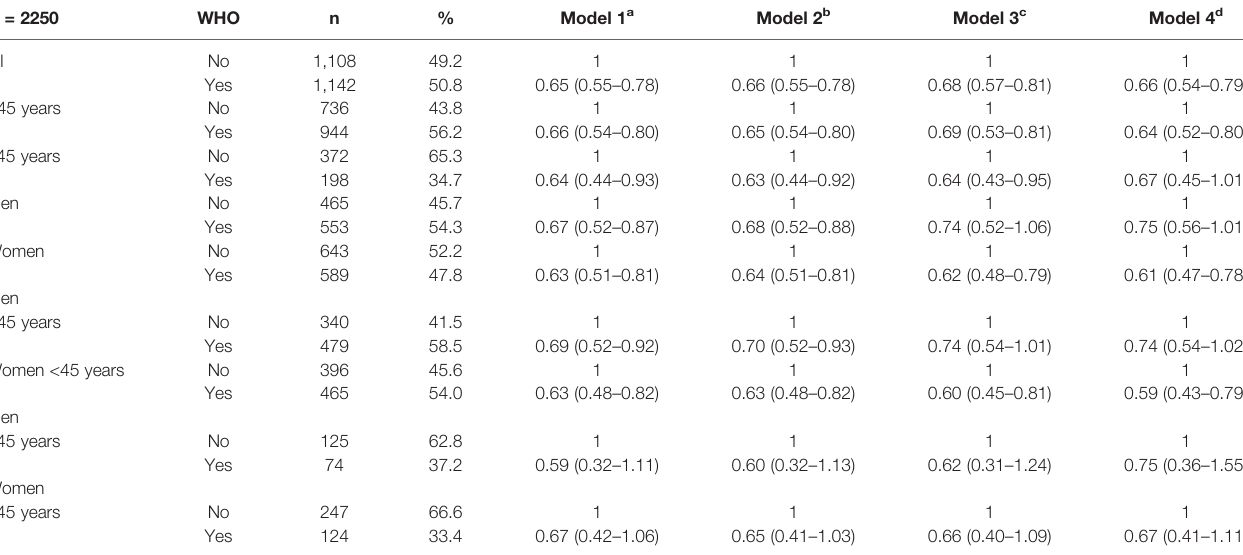
TABLE 2 | Adjusted odds ratios (95% con fi dence interval) for higher current perceived anxiety than usual in relation to WHO physical activity guidelines (reference: less than 150 weekly minutes of physical activity) in the entire study population and in age and gender